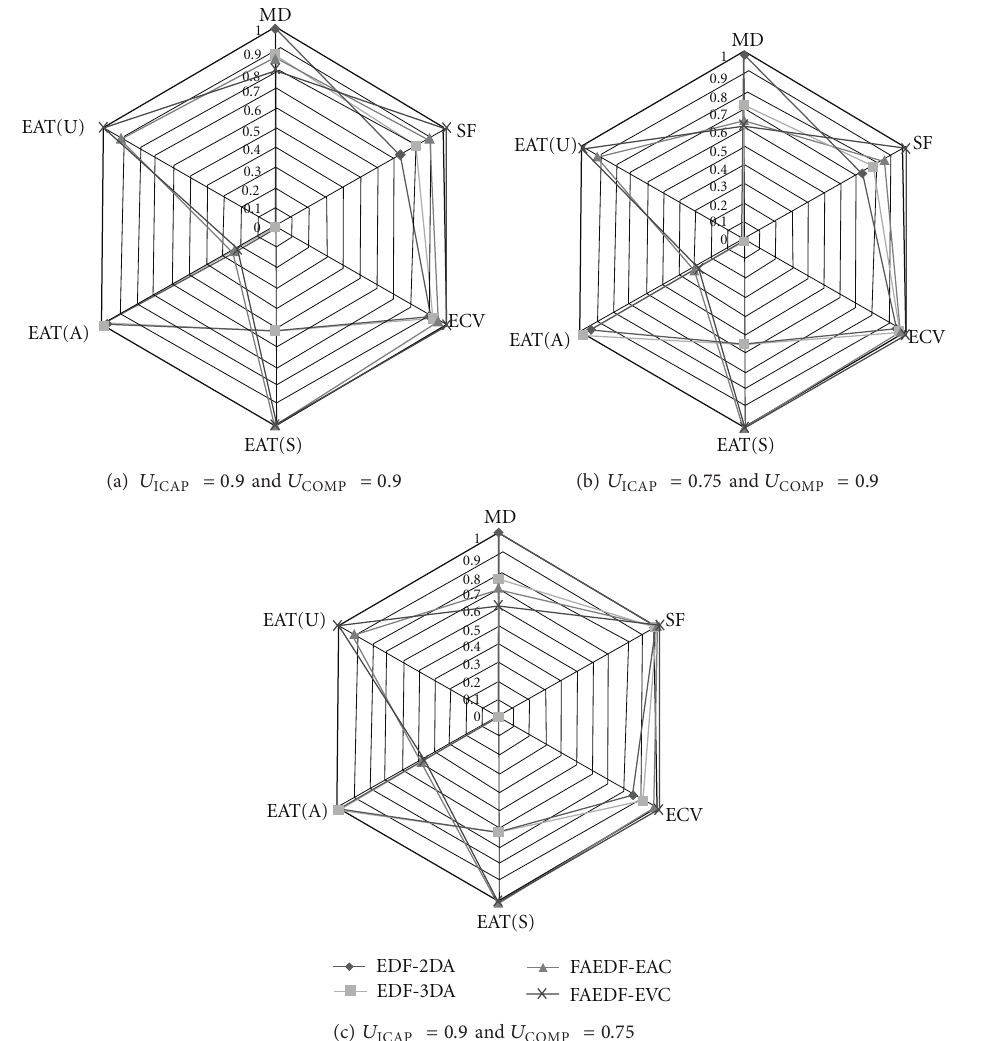
Figure 13: Performance with no damage in the FPGA device. EAT(U) refers to the EAD updating time, EAT(A) refers to the time needed for making the allocation decisions, and EAT(S) is the time needed for making the scheduling